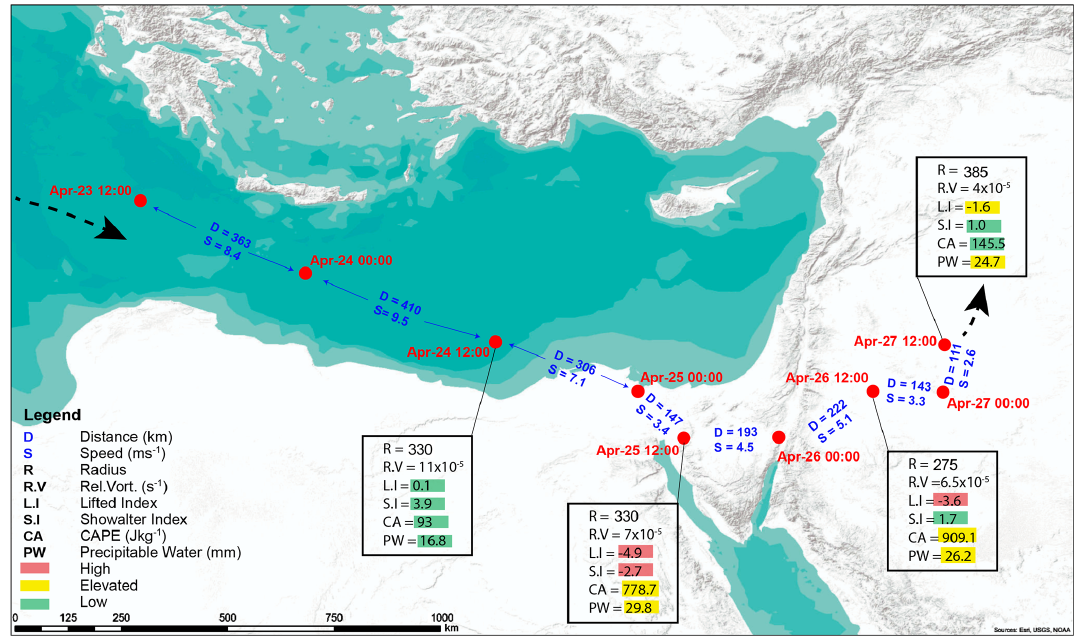
Figure 3. Track of the upper-level cyclone (500hPaGPH) during 24–27 April 2018 in 12h intervals. The instantaneous speed (ms − 1 ) and distance (km) spanned during each increment are denoted by S and D , respectively. For each 24h increment, the radius of the upper-level low (km), the maximum relative vorticity (s − 1 ), the precipitable water (PW, in mm) and three thermodynamic indices (LI, SI and CA) as calculated from the sounding of Beit Dagan are specified. “High”, “Elevated” and “Low” values of the indices are highlighted in red, yellow and green,